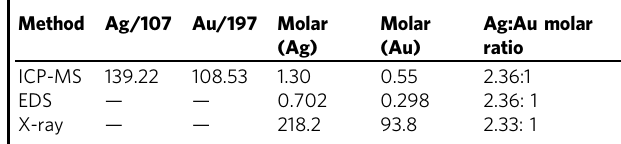
Fig. 2 Representative molecular structure of the plasmonic (AuAg) 267 nanoparticle. a Buckyball-shape (AuAg) 267 nanoparticle. b Layered ABCAC packing (or ABCB if the central Ag atom is ignored) of metal atoms. c – f Anatomy of metal framework of (AuAg) 267 nanoparticle: the fi rst Mackay icosahedral shell ( ʋ 1 ) with 12 M atoms ( c ); the second Mackay icosahedral shell ( ʋ 2 ) with 42 M atoms ( d ); the third Mackay icosahedral shell ( ʋ 3 ) with 92 M atoms ( e ); and the fourth anti-Mackay shell ( ɷ 4 ) with 120 Ag atoms ( f ). g Three-fold coordinated thiolate centered on six-Ag- atom triangle (highlighted in blue in panels ( f ) and ( g ). h Two tetradentate thiolates capped on two edge-shared squares (highlighted in yellow in panels ( f ) and ( h ). i Sulfur atoms (yellow) arranged in a slightly distorted truncated icosahedron (buckyball). All hydrogen and carbon atoms are omitted for clarity. Color code: sea green and red AuAg, blue Ag, yellow